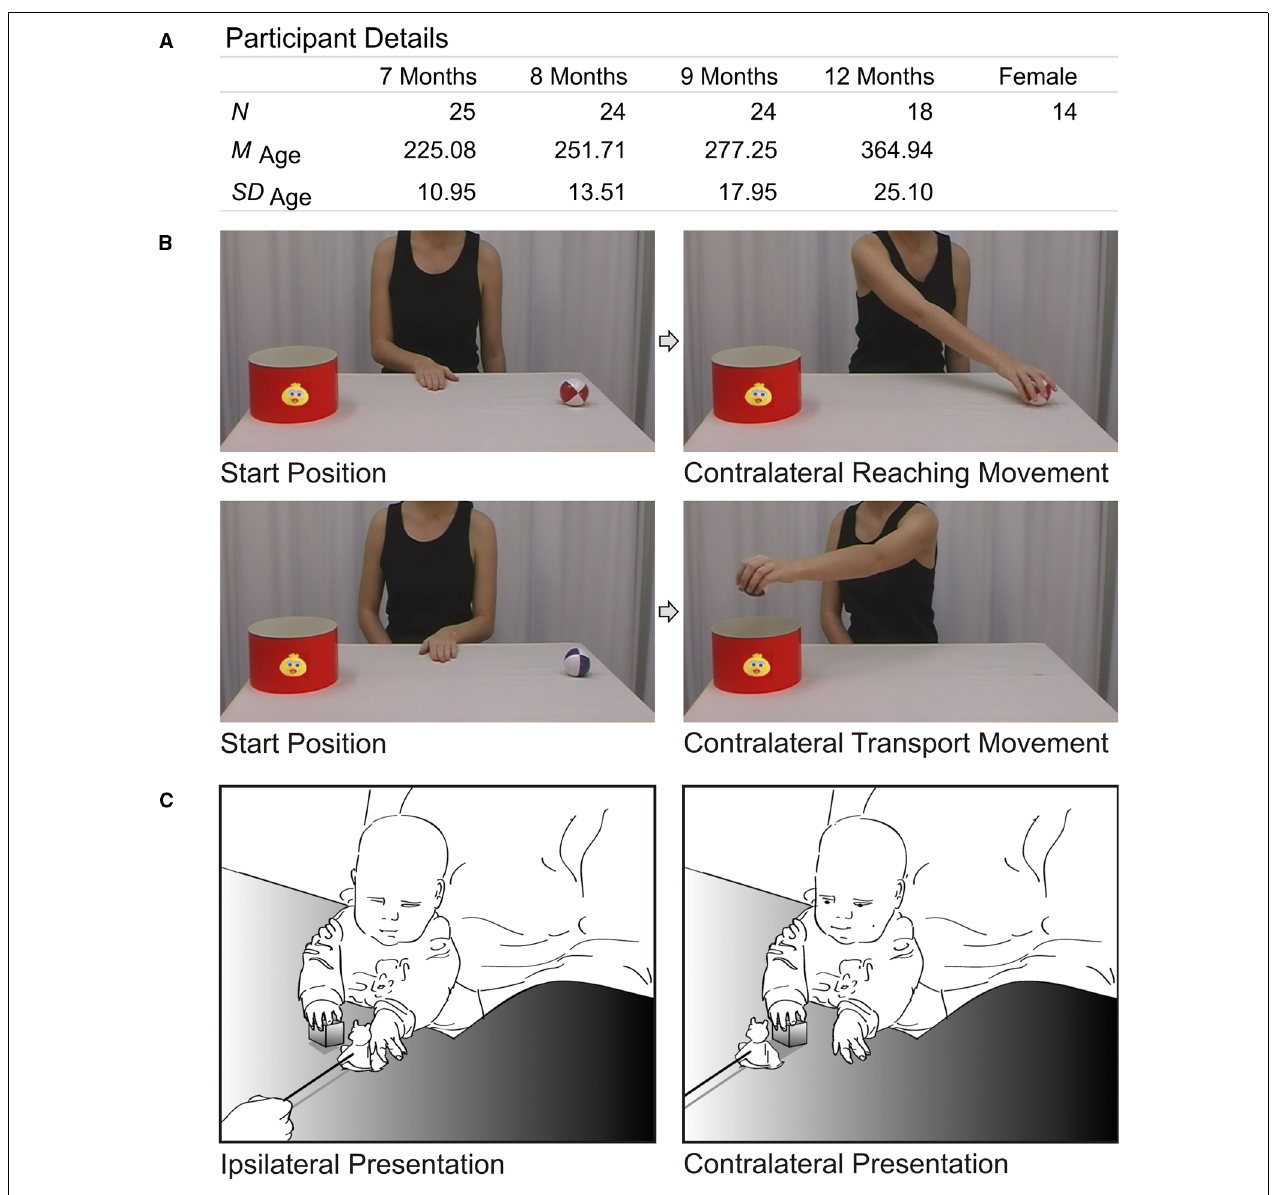
FIGURE 1 | Methods. (A) Participant details, including number of participants per measuring point, mean age in days (and standard deviation), and number of females in the sample. (B) Screen shots of the perception task. Upper row illustrates a trial with a contralateral reaching movement (and, therefore, an ipsilateral transport movement, not shown). Lower row illustrates a trial with a contralateral transport movement (and preceding ipsilateral reaching movement, not shown). While observing the actions, infants’ eye movements were recorded using an eyetracker (SR Research Eyelink Plus, 500 Hz, monocular). As perception measure, we calculated the anticipation frequency for contralateral movements, that is, the number of trials in which the gaze arrived at goal areas (i.e., ball AOI and bucket AOI)